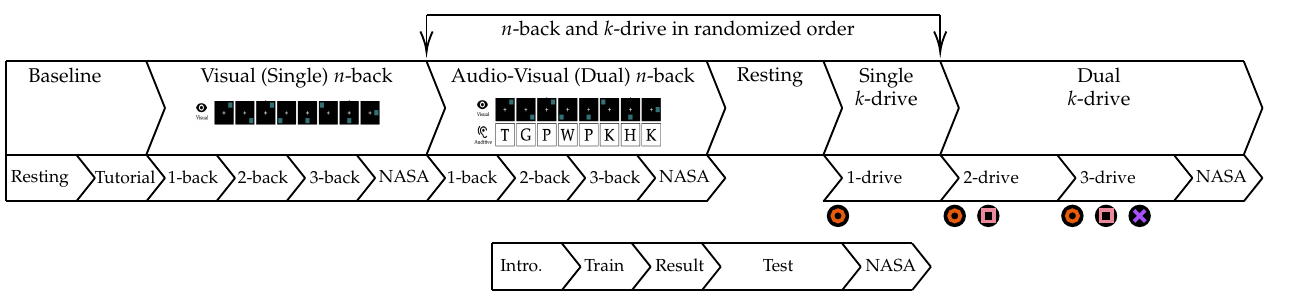
Figure A2. Visualization of a complete experimentation sequence with two experiments, n -back during single and dual-task load with three levels each, followed by a NASA-TLX questionnaire for each dimension. The n -back test is then concluded by a weighting of every NASA-TLX dimension and followed by a resting phase, where the subject answered the questionnaires described in Section 2.1. During k -drive the subject is conducting three levels k 1,2,3 with tasks described in Section 2.3. ∈ { } 1-drive is conducted during a single-task load and 2/3-drive during dual-task load. The detailed sequence of one level for n -back and k -drive is depicted in the sequence diagram below the main diagram and holds for all n -back and k -drive tests.